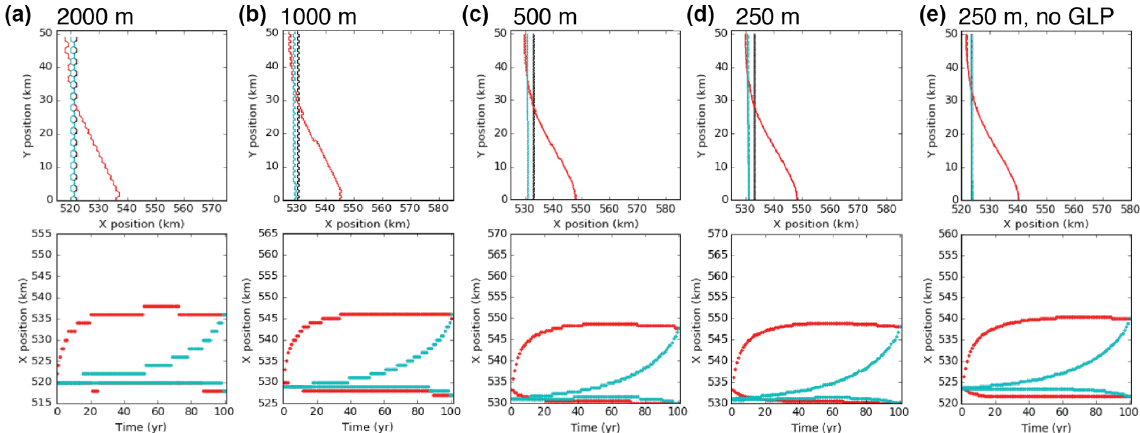
Figure 11. Results of the MISMIP3d P75R and P75S experiments from MALI at increasing grid resolution: (a) 2000m, (b) 1000m, (c) 500m, (d) 250m. Results for 250m without grounding line parameterization (e) are also shown for reference. Plots follow conven- tions of Figs. 5 and 6 in Pattyn et al. (2013). Upper plots show steady-state grounding line positions for steady-state spin-up (black), P75S (red), and P75R (blue) experiments. Lower plots show grounding line position with time for P75R (red) and P75S (blue) at y = 0km (top curves) and y = 50km (bottom curves). 500 and 250m results are nearly identical. 250m results without grounding line parameterization are intermediate of those at 1000 and 2000m resolution with grounding line